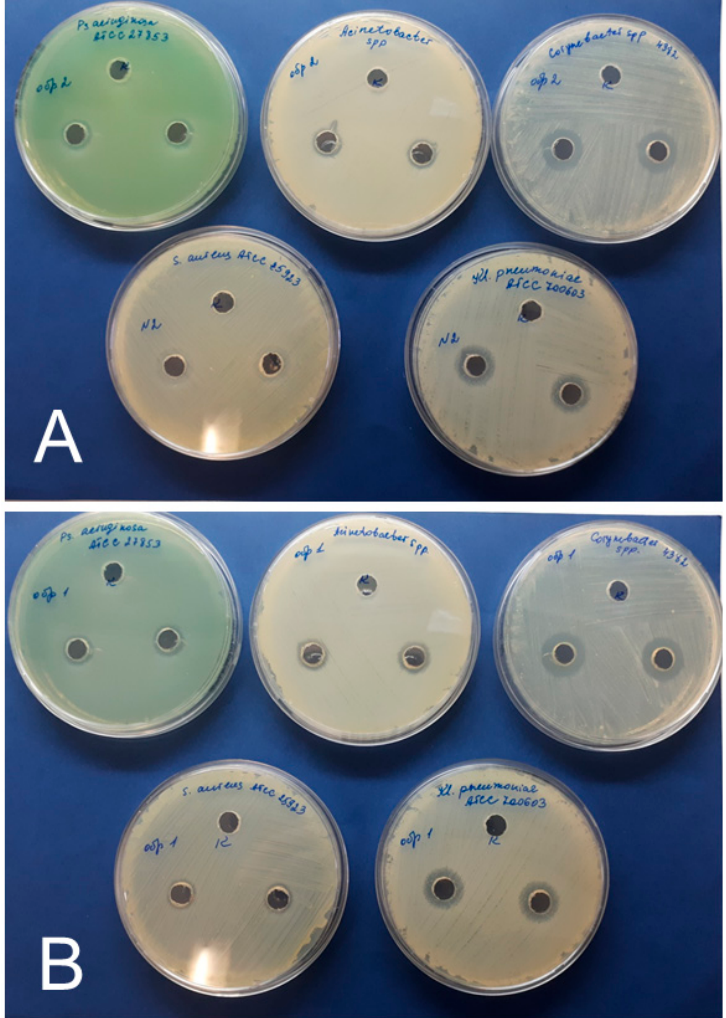
Figure 7. Representative figures of the inhibition zone test of ( A ) AgNPs–SS and ( B ) AgNPs–Alb